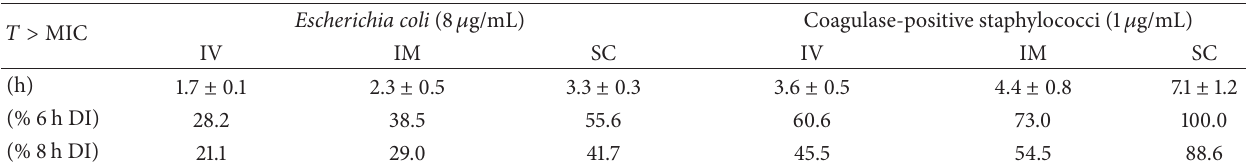
Table 3: Time above MIC 90 ( 𝑇 > MIC) calculated for cephalexin following an intravenous (IV), intramuscular (IM), and subcutaneous (SC) 10mg/kg injection to 6 llamas. Results (mean ± SD) are expressed in hours (h) and dosing interval (DI) percentage.